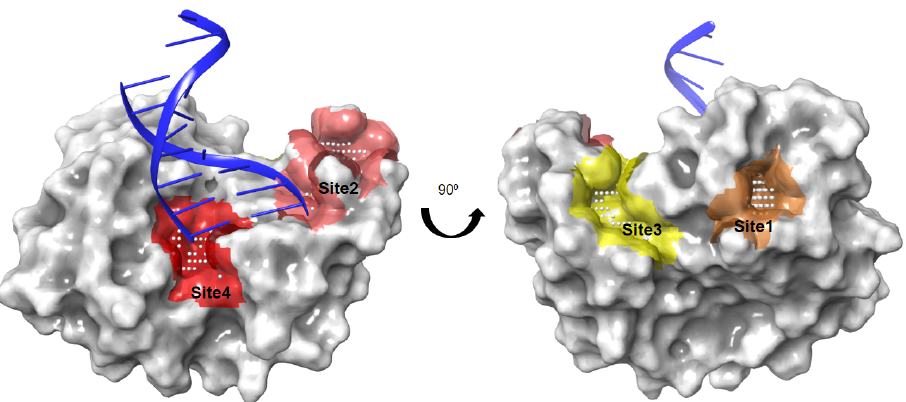
Figure 1. The four top-ranking surface pockets observed in the Asfv PolX protein identified by the SiteMap module of Schrödinger. Colored spaces represent the SiteMap predictions for four top- ranking surface clefts on the Asfv PolX protein (PDB ID: 5HRB, in grey surface representation): site 1: orange, 2: pink, 3: yellow, 4: red. The red and pink spaces correspond to the DNA binding site. Grey dots represent the cavity of the putative active site of the protein.